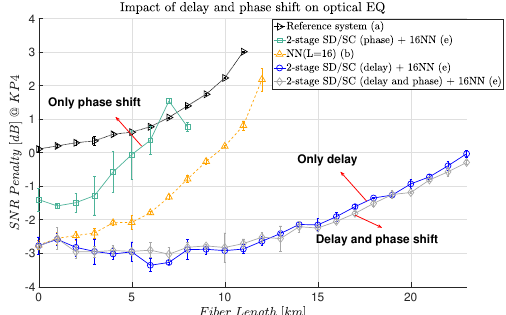
Figure 7. Simulation results to analyze the impact of delay and phase shift in the hybrid two-stage SD/SC structure. The receiver topology considered in Figure 2 is highlighted inside the parentheses in the legend of the figure.